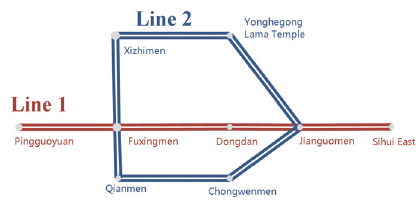
Figure 7: An example of a metro network extracted from Beijing metro